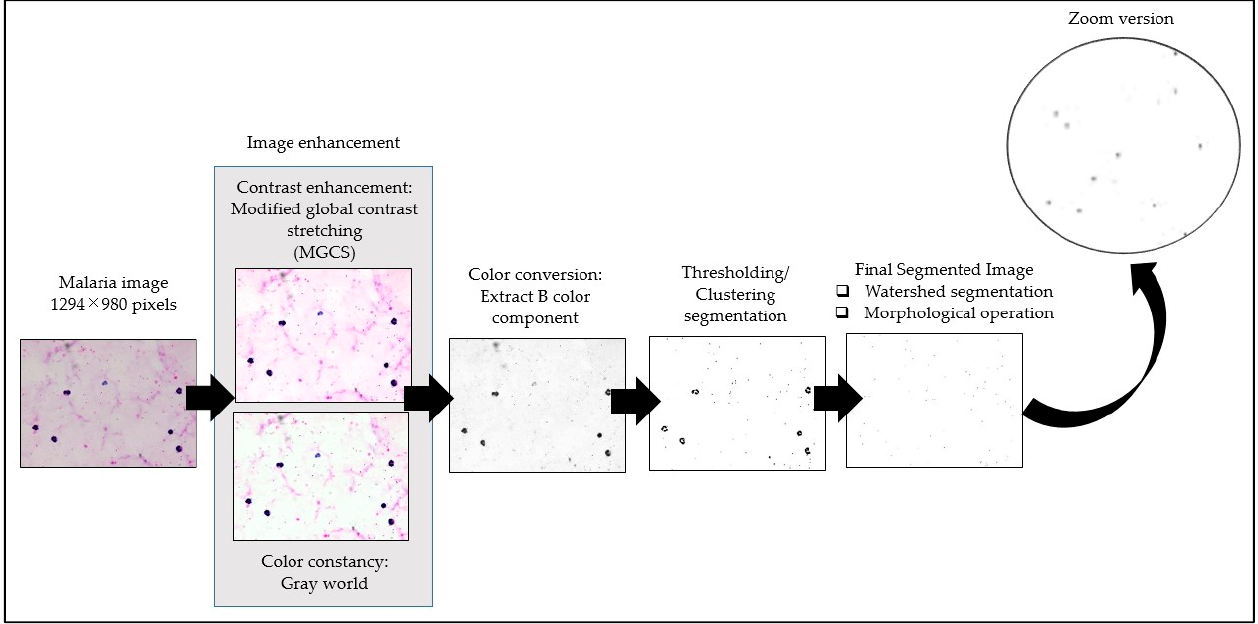
Figure 3. The framework of the proposed image-processing procedure for thick smear segmenta- tion.